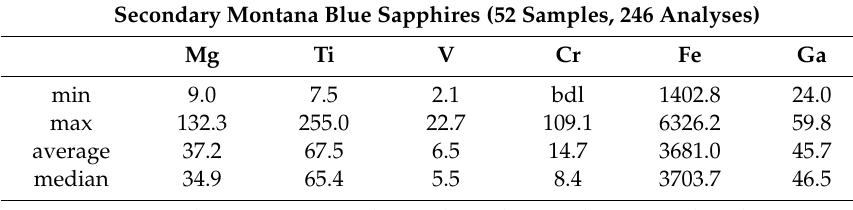
Table 7. Summary of trace elements for secondary Montana sapphires and rubies in